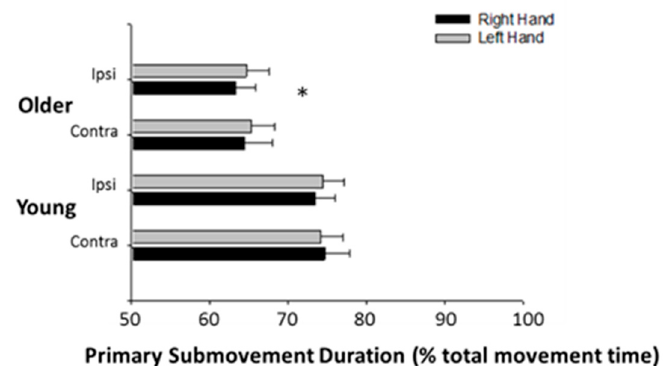
Figure 4. Primary submovements are relatively shorter in older adults. Primary submovements duration normalized by total movement time was shorter for older adults (* p < 0.01). There were no differences between hands or ipsilateral and contralateral movements.